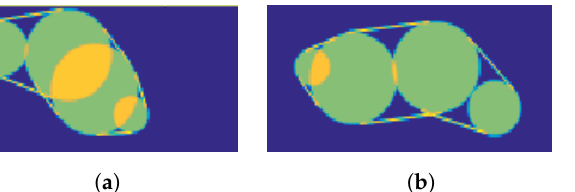
Figure 1. Examples of two simulated objects of ( a ) normal and ( b ) elongated shapes. Four green circles represent the body (the two largest circles in the center), the head (medium-sized circle), and the tail (smallest circle), respectively. Their relative positions determine the shape of the animal’s body.